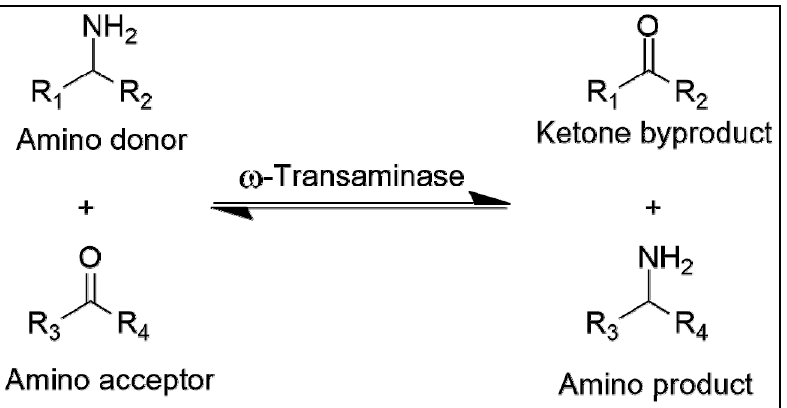
Figure 1. Schematic of transamination catalyzed by transaminases.